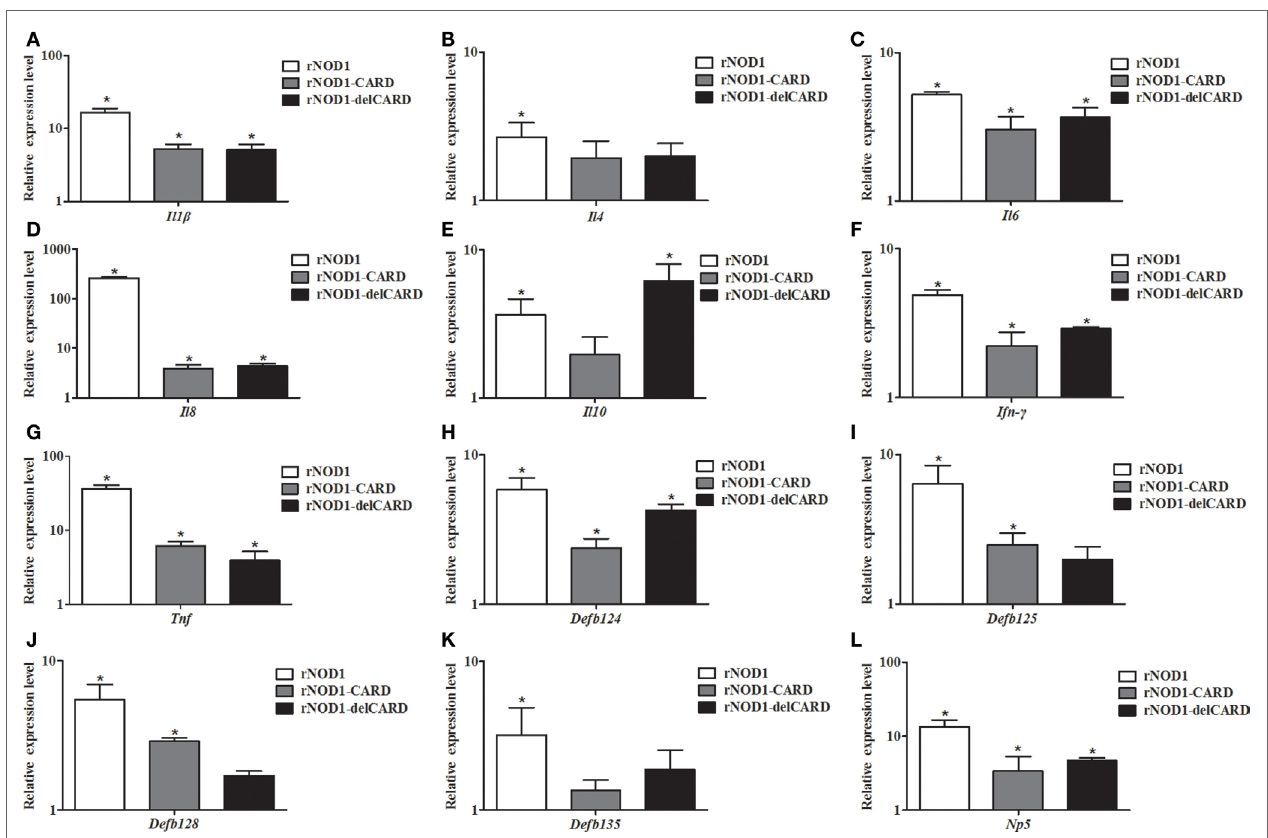
FigUre 4 | Expression profiles of immune-related genes in RK-13 cells. Two microgram of pC-rNOD1, pC-rNOD1-CARD, pC-rNOD1-delCARD, and pCDNA3.1- empty were transfected for 24 h. The Effects of the overexpression of different rNOD1 domains on expression of (a) Il1b , (B) Il4 , (c) Il6 , (D) Il8 , (e) Il10 , (F) Ifn- γ , (g) Tnf , (h) Defb124 , (i) Defb125 , (J) Defb128 , (K) Defb135 , and (l) Np5 were determined. M ± SD from three independent experiments are presented. Significant differences are indicated by